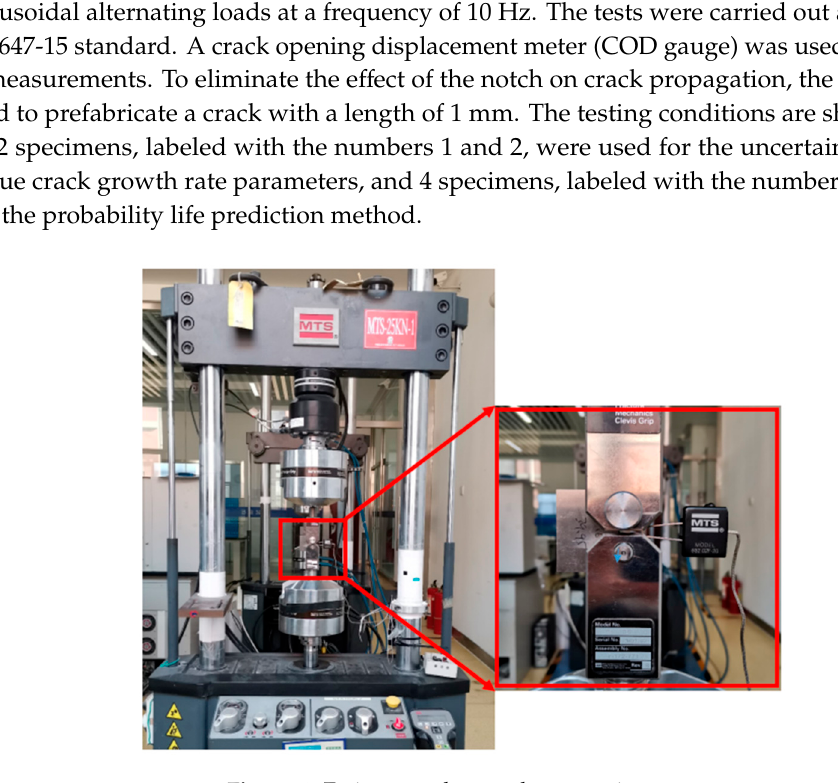
Figure 4. Fatigue crack growth test equipment.